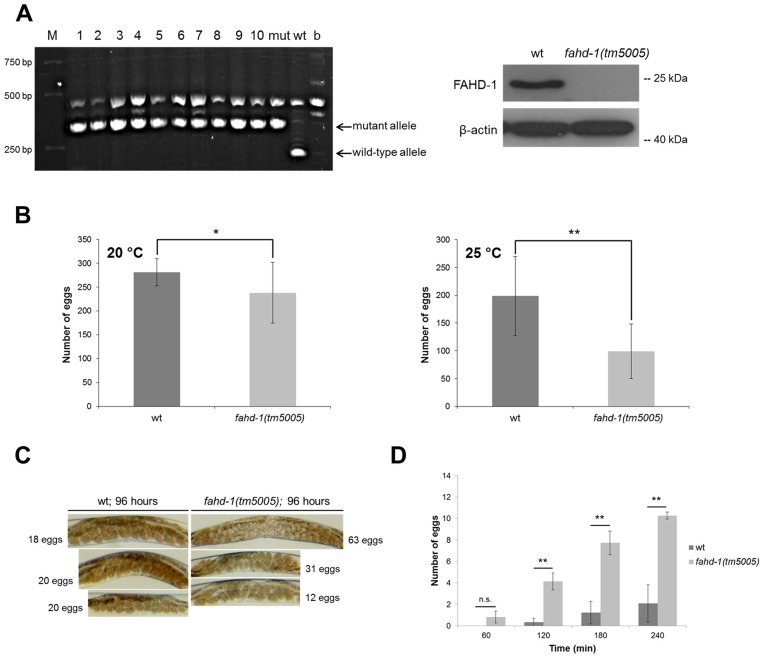
Characterization of fahd-1 deletion mutant animals.(A) Left panel: Single worm duplex PCR was performed on ten animals of the fahd-1(tm5005) mutant strain, to confirm the deletion on DNA level. Three primers were used, generating PCR products of 220 bp for the wild-type allele and 337 bp for the mutant allele. M = size marker; 1–10 = 10 different backcrossed fahd-1(tm5005) C. elegans; mut = mutant allele; wt = wild-type allele; b = E. coli OP50 (C. elegans bacterial food; to identify bands derived from bacterial contamination). Right panel: To confirm the deletion of the protein, protein lysates were prepared from wild-type and fahd-1(tm5005) mutant animals, as indicated. FAHD-1 protein was detected by Western blot using a peptide-specific rabbit polyclonal antibody against FAHD-1. β-actin served as a loading control. (B) Overall brood size was compared by counting progeny in wild-type and fahd-1(tm5005) C. elegans animals raised at 20°C and 25°C throughout the reproductive period. In fahd-1(tm5005) C. elegans the total brood size is reduced compared to wild-type controls when raised at 20°C (left panel; 281 ±SD 28.11 for wt vs. 238 ±SD 63.96 for fahd-1(tm5005); p = 0.05; N = 9) and even more severe when raised at 25°C (right panel; 199 ±SD 71.30 for wt vs. 98.8 ±SD 49.23 for fahd-1(tm5005); p = 0.0013; N = 10). (D) Egg laying patterns were determined for wild-type and fahd-1(tm5005) C. elegans. Left panel: 4-day old wild-type and fahd-1(tm5005) animals were kept in M9 buffer (without bacteria) for four hours and the number of eggs that were laid by each genotype during this time was counted. While wild-type worms do not lay their eggs under these unfavorable conditions, fahd-1(tm5005) worms ‘lose’ them over the course of time (2.08 ±SD 1.75 for wt vs. 10.26 ±SD 0.32; p = 0.0598 for 60 min, p < 0.002 in all other cases; N = 3 experiments (72 worms total)). Right panel: Micrographs were prepared from 4-day old, well-fed and unstressed hermaphrodites of the wild-type and fahd-1(tm5005) genotype. While wild-type worms carry between 18 and 20 eggs, fahd-1(tm5005) animals show great variety in the number of eggs, tending to accumulate them in the uterus. Representative pictures are shown.